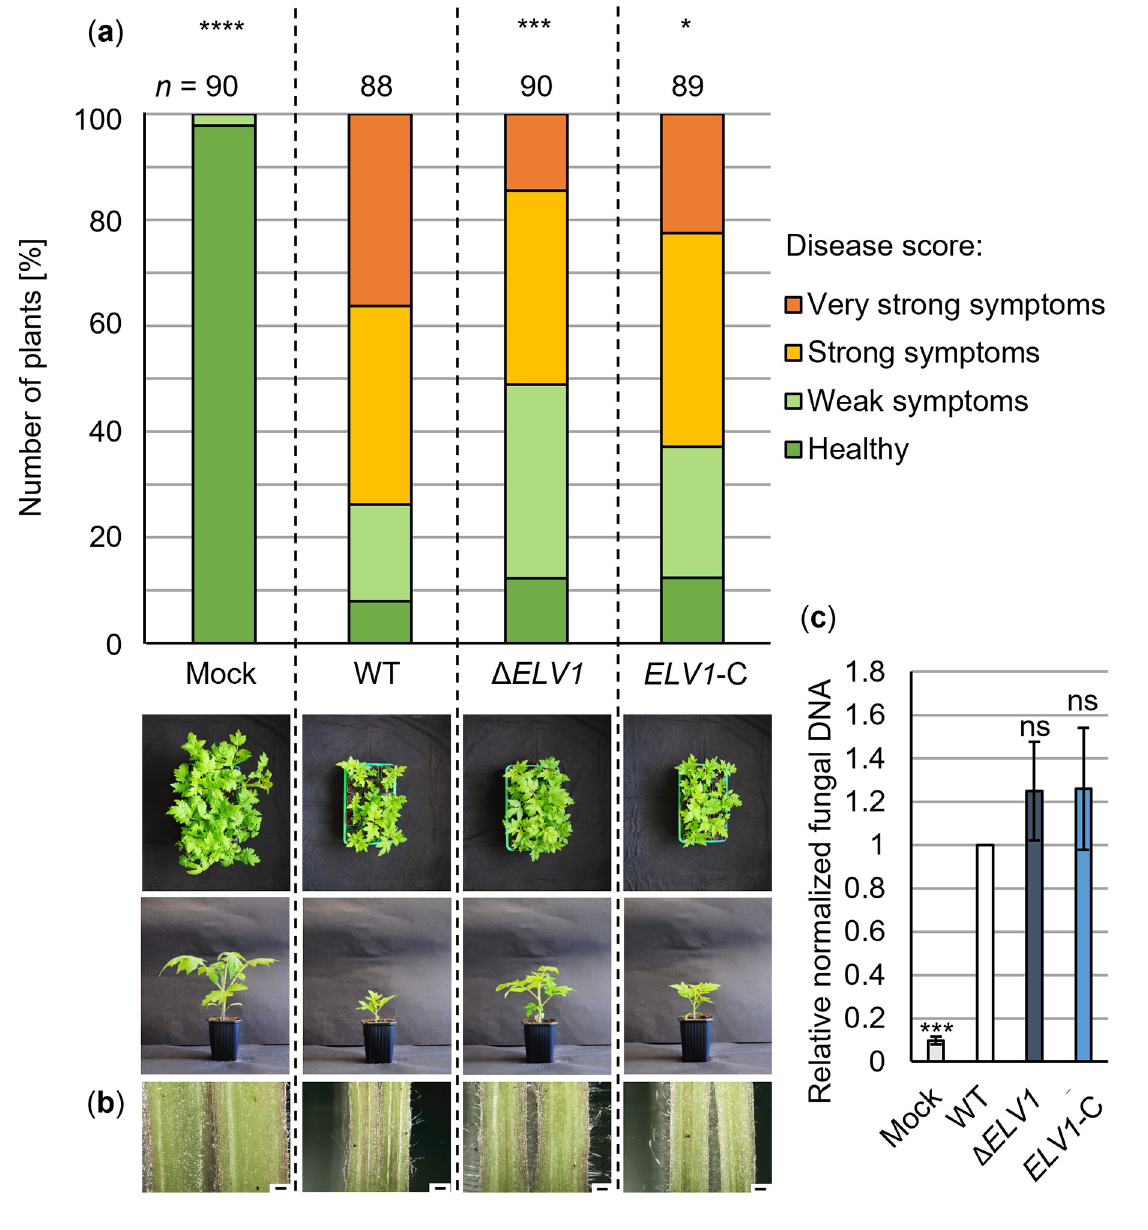
Fig 4. Verticillium dahliae Elv1 contributes to virulence on tomato plants. The in-planta phenotype of the V . dahliae ELV1 deletion strain ( Δ ELV1 ) was compared with the JR2 wild-type (WT) and the complementation strain ( ELV1 -C). Tomato seedlings (10-day-old) were treated with spores or water (mock) by root-dipping. The plants were incubated in a climate chamber under 16 h: 8 h light: dark at 22–25˚C. The experiment was performed twice. (a) The disease score was determined at 21 dpi and includes plant height, longest leaf length and plant weight. The relative number of plants with certain disease scores is summarized in the stack diagram ( n = number of treated plants). Significance was calculated using two-tailed Mann-Whitney U tests ( � , P < 0.05; ��� , P < 0.001; ���� , P < 0.0001). Treatment of tomato seedlings with Δ ELV1 spores resulted in approximately 25% more plants exhibiting no or only weak symptoms compared with wild-type-infected plants. An overview of plants and a single representative plant per treatment are shown. (b) Cross-sections of representative hypocotyls (scale = 500 μ m) depict discoloration in plants treated with wild-type, ELV1 deletion or complementation strains, but not in mock-inoculated plants. (c) Fungal DNA was analyzed by quantitative PCR relative to plant DNA purified from 14 to 15 hypocotyls per treatment ( n = 1). Shown are the means of six biological replicates ± SE of the mean. Significance was calculated using t -tests (ns, not significant; ��� , P < 0.001). Significantly less fungal DNA was detected in mock than in fungus-inoculated plants.